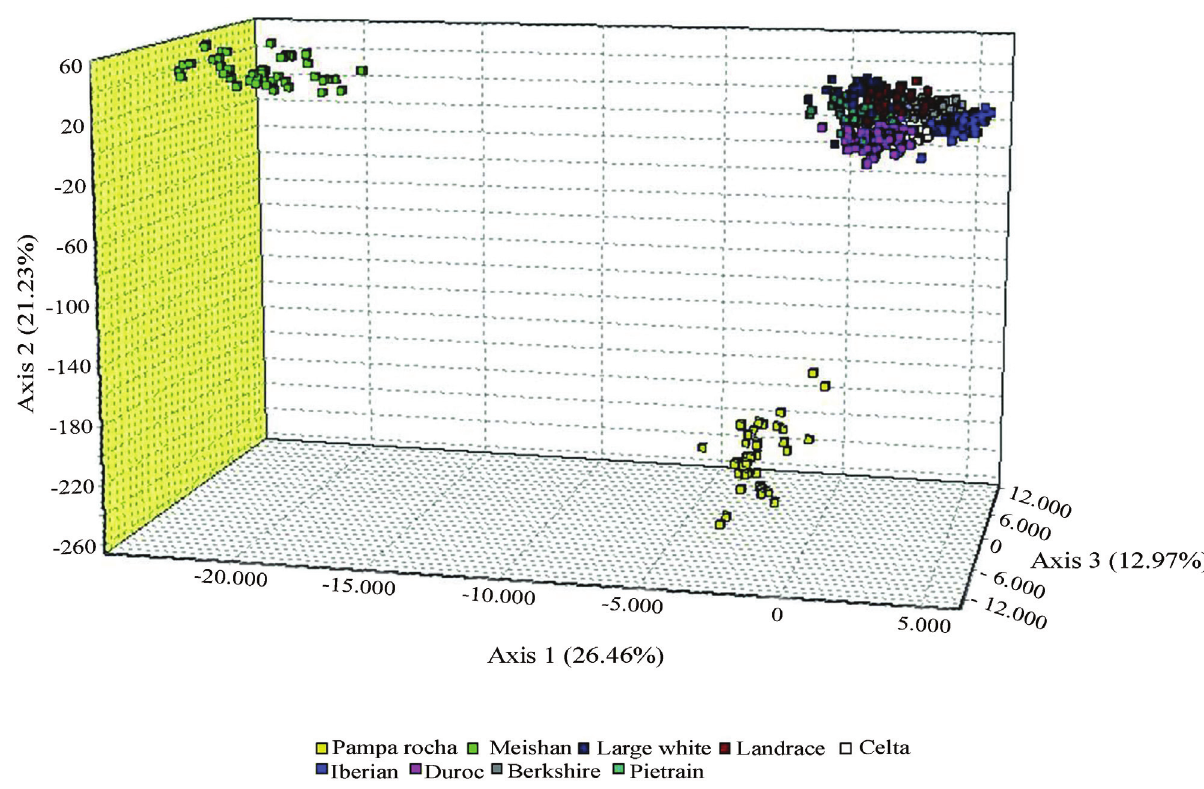
Figure 1 - Graphical representation of the factorial analyses of correspondence.